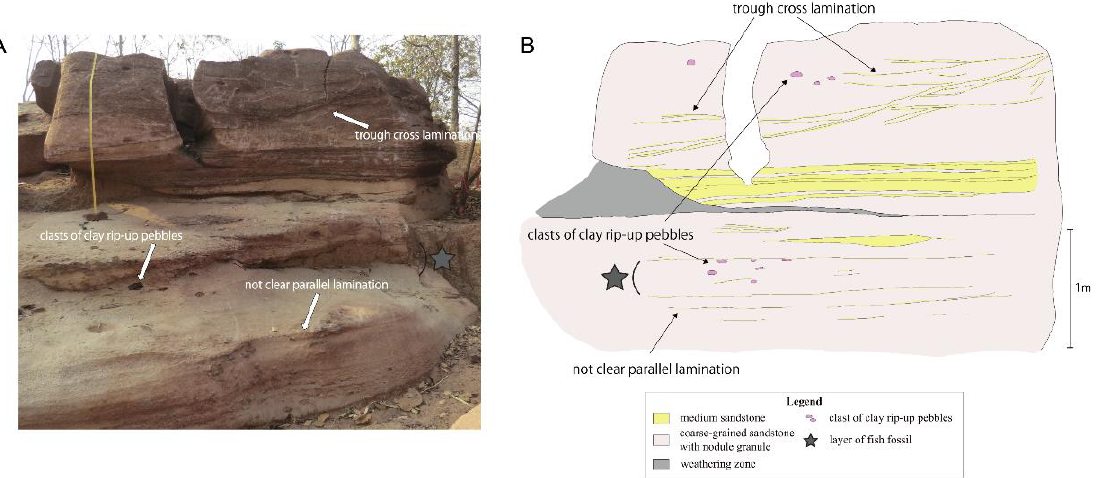
Figure 2. ( A ) The section of the sample collection and ( B ) stratigraphic section of the study